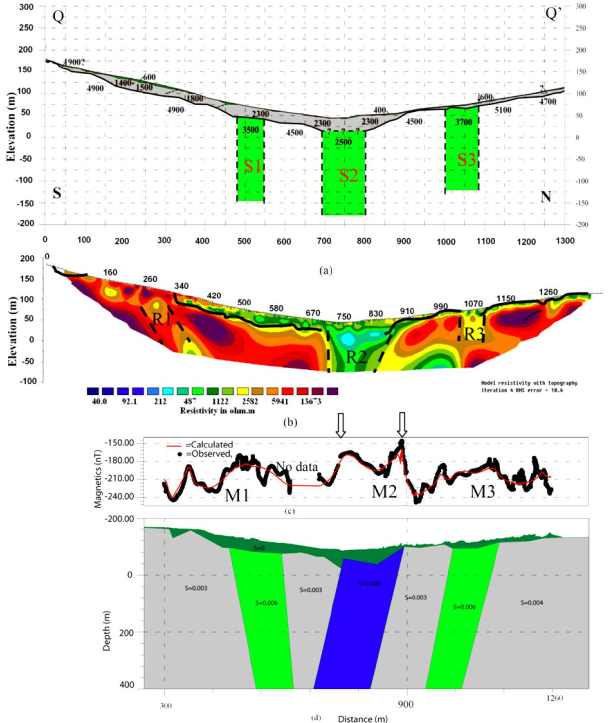
Fig. 6. Geophysical profiling across the Tjellefonna Fault. (a) The refractionseismic profile shows three low-velocity zones (S1, S2 and S3); velocities in ms − 1 . (b) Depth-inverted 2-D-resistivity pro- file showing three low-resistivity zones (R1, R2 and R3). Continu- ous and dashed lines represent the interpreted top bedrock and the edges of the interpreted main fault zone, respectively. (c) Magnetic profile. The arrows on top of the magnetic anomaly show the edges of the interpreted main fault zone. Profile locations are shown in Figs. 3 and 5. (d) A model is proposed for magnetic